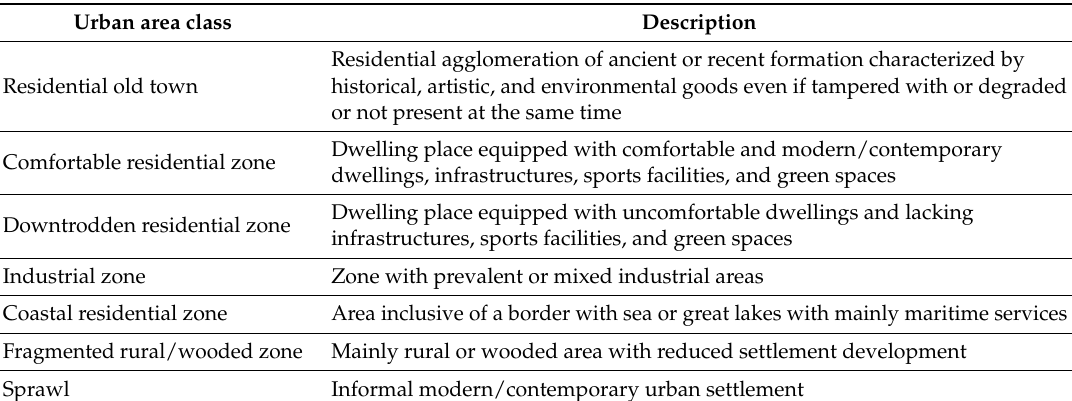
Table 3. Urban area classes.